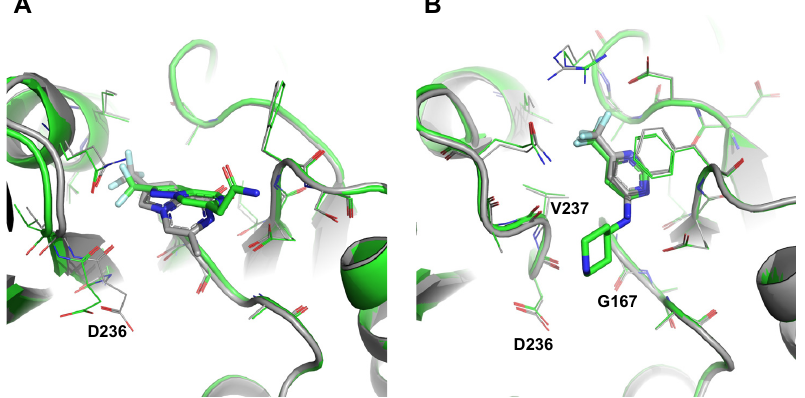
Figure 6. hFBL crystal structures with fragment derivatives. ( A ) Superimposition of the hFBL: 1 (grey) and hFBL: 1a (green) complexes. ( B ) Superimposition of the hFBL: 2 (grey) and hFBL: 2a (green) complexes. Ligand and interacting residues are displayed in thick and thin stick representation, respectively (oxygen, red; nitrogen, blue; fluorine, pale cyan). The protein backbone is displayed in cartoon representation.